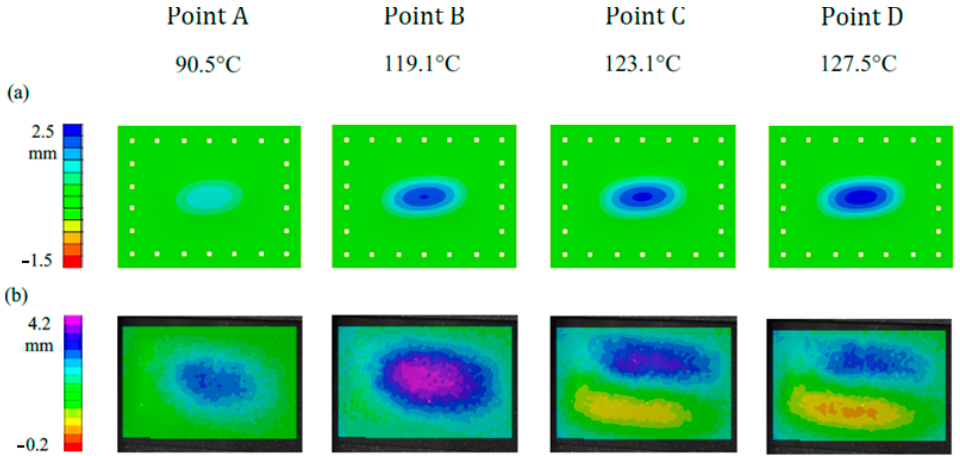
Figure 16. Heating cycle for [35/−35/10/−10] (cid:3046) composite plate.